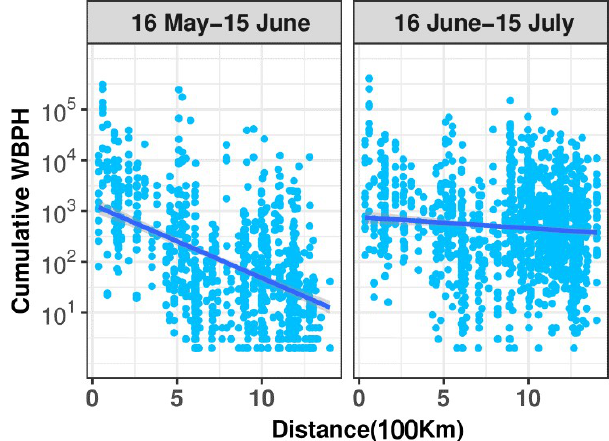
Figure 5. The relationship between the WBPH immigration volume and migration distance. Yongfu station in Guangxi was used as the starting point. PPS sites located northeast of Yongfu were selected and the distances from Yongfu to each selected station were calculated.